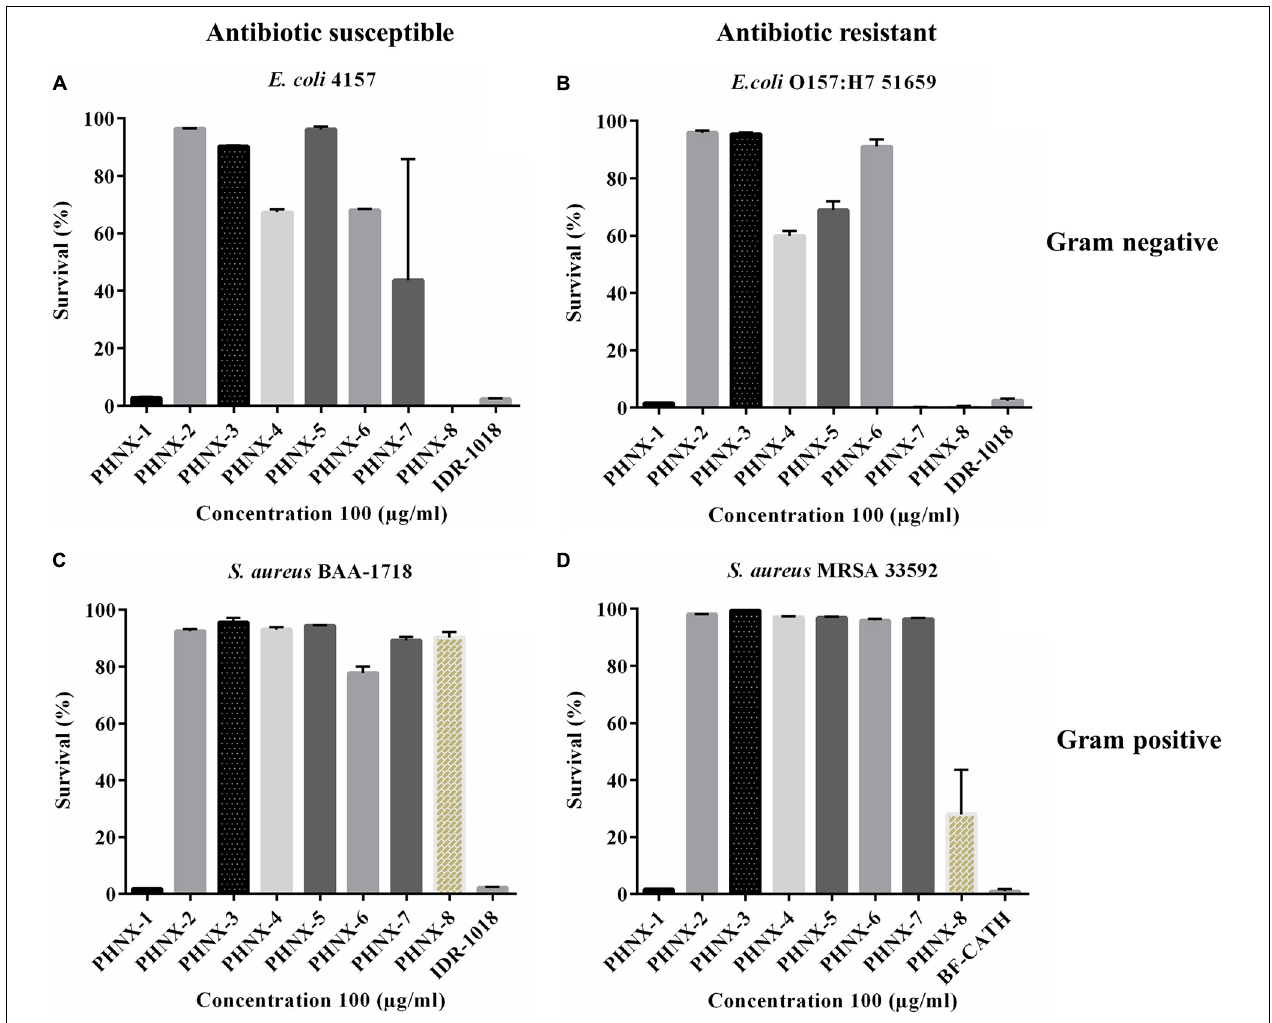
FIGURE 3 | Antibacterial screening of PHNX-peptides and controls (IDR-1018 and BF-CATH) at 100 µ g/ml against. (A) Antibiotic susceptible Escherichia coli 4157. (B) Staphylococcus aureus BAA-1718. (C) Antibiotic resistant E. coli O157:H7 51659. (D) S. aureus MRSA 33592 where PHNX-1 led to almost 0% bacterial survival against all strains and PHNX-7 and -8 against the Gram-negative